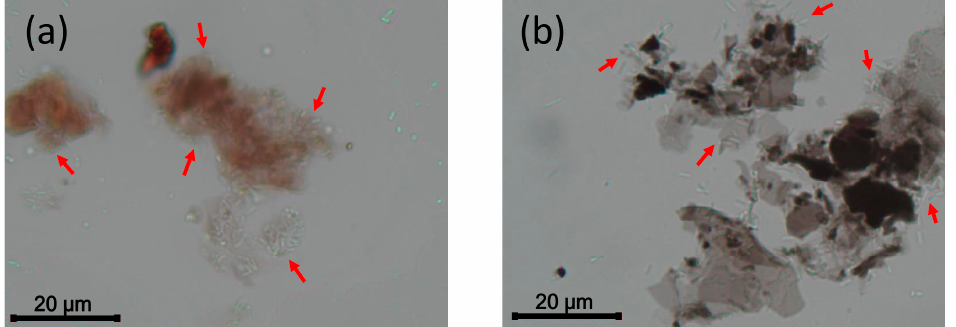
Figure 1. OM images of ( a ) S. decolorationis NTOU1 cells with GO at 0 h, and ( b ) S. decolorationis cells with rGO after 24 h of reaction (arrows indicate the location of bacterial cells colonizing).